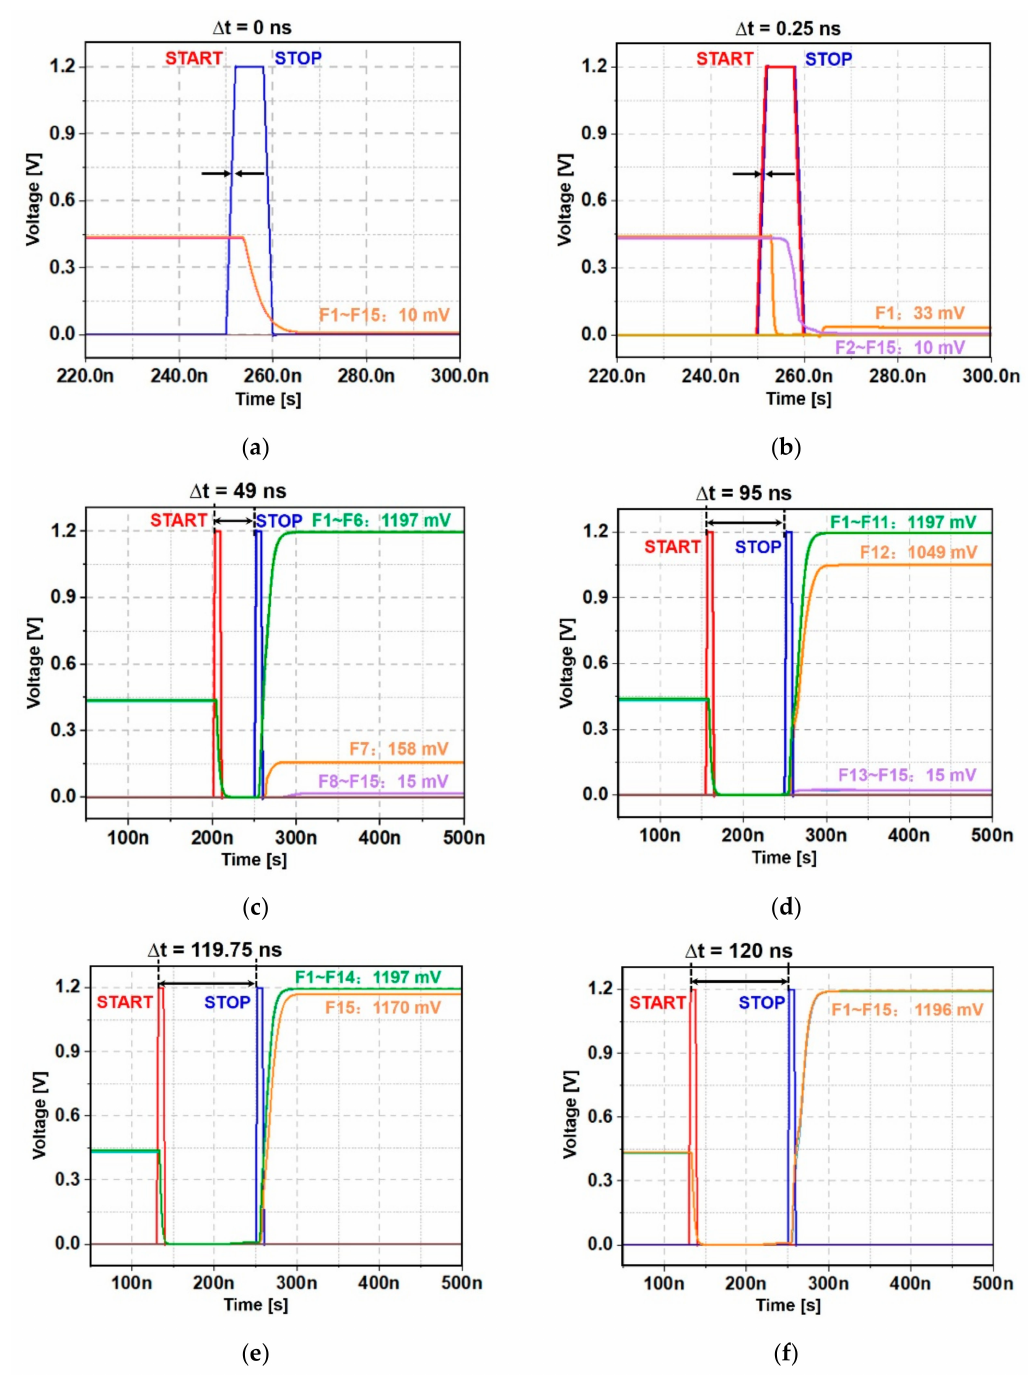
Figure 5. Simulated results of the proposed I-TDC for ( a ) no time interval, ( b ) 0.25 ns, ( c ) 49 ns, ( d ) 95 ns, ( e ) 119.75 ns, and ( f ) 120 ns time